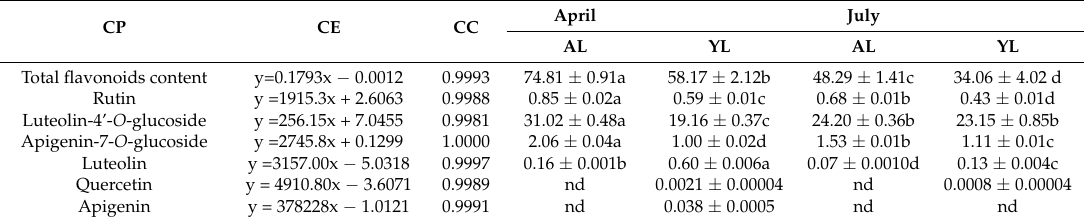
Table 3. Compounds (CP), calibration equations (CE), correlation coefficients (CC), and quantification of flavonoid compounds from the aged and young leaves (AL and YL) in April and July *.